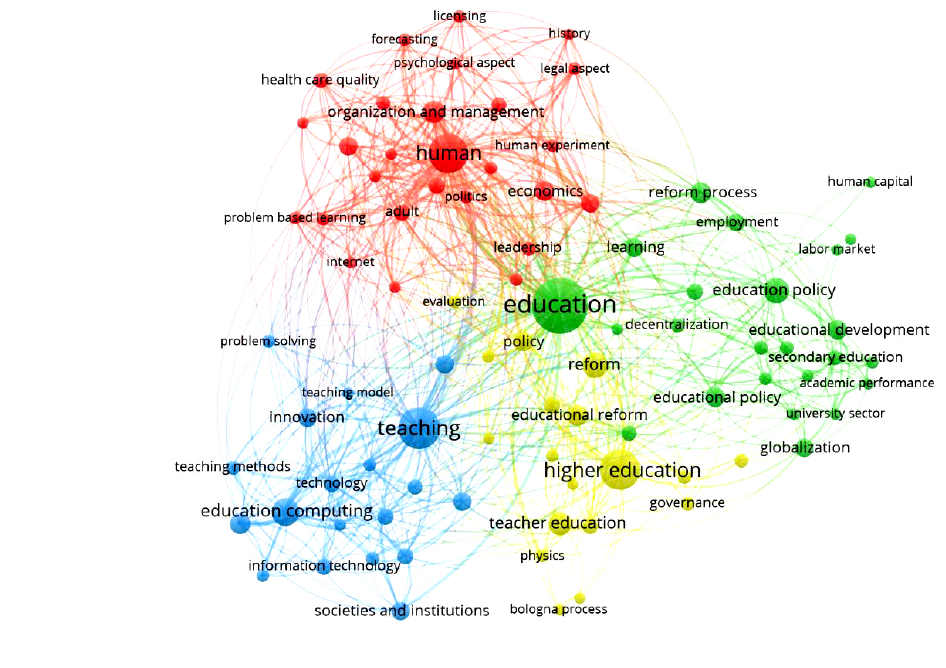
Figure 3. The visualizing map of co-occurrence of the keywords in papers of a dataset (initial search query of the keywords “reforming” AND “education”)